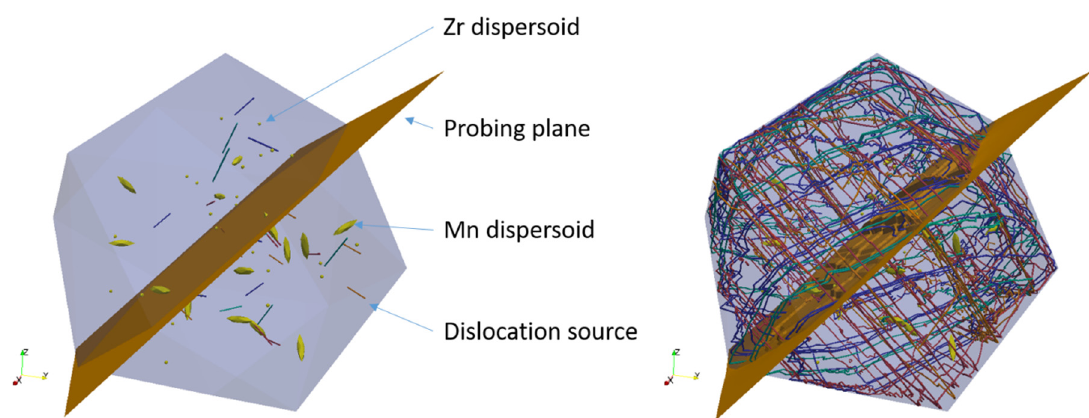
Figure 3. Initial and final configuration of a typical DDD simulation of a spherical volume of 5 µm diameter containing an assortment of small spherical zirconium dispersoids, elongated manganese dispersoids, and Frank Read dislocation sources. Strain localization will be estimated from the plastic steps printed in the probing plane inserted in the middle of the simulated volume.